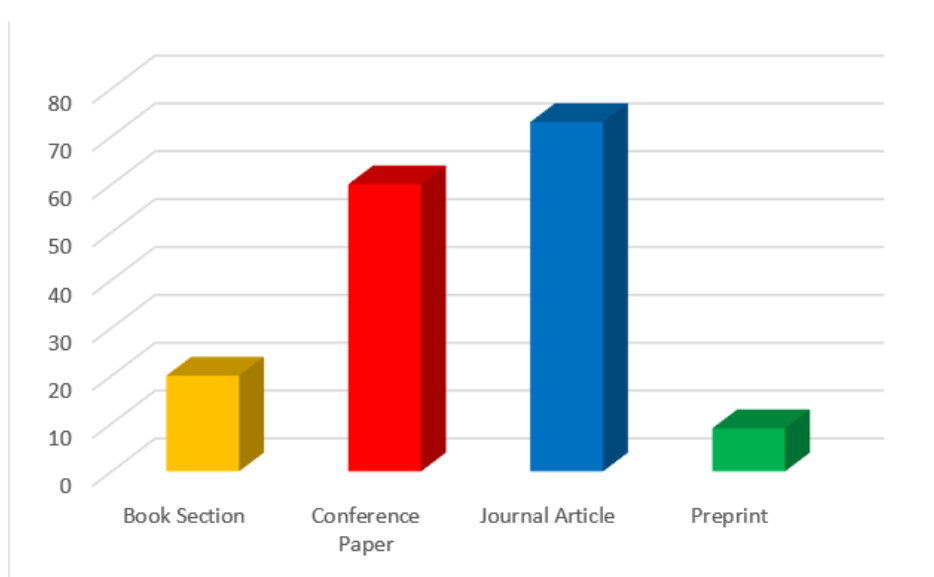
Figure 4. Publications per type.